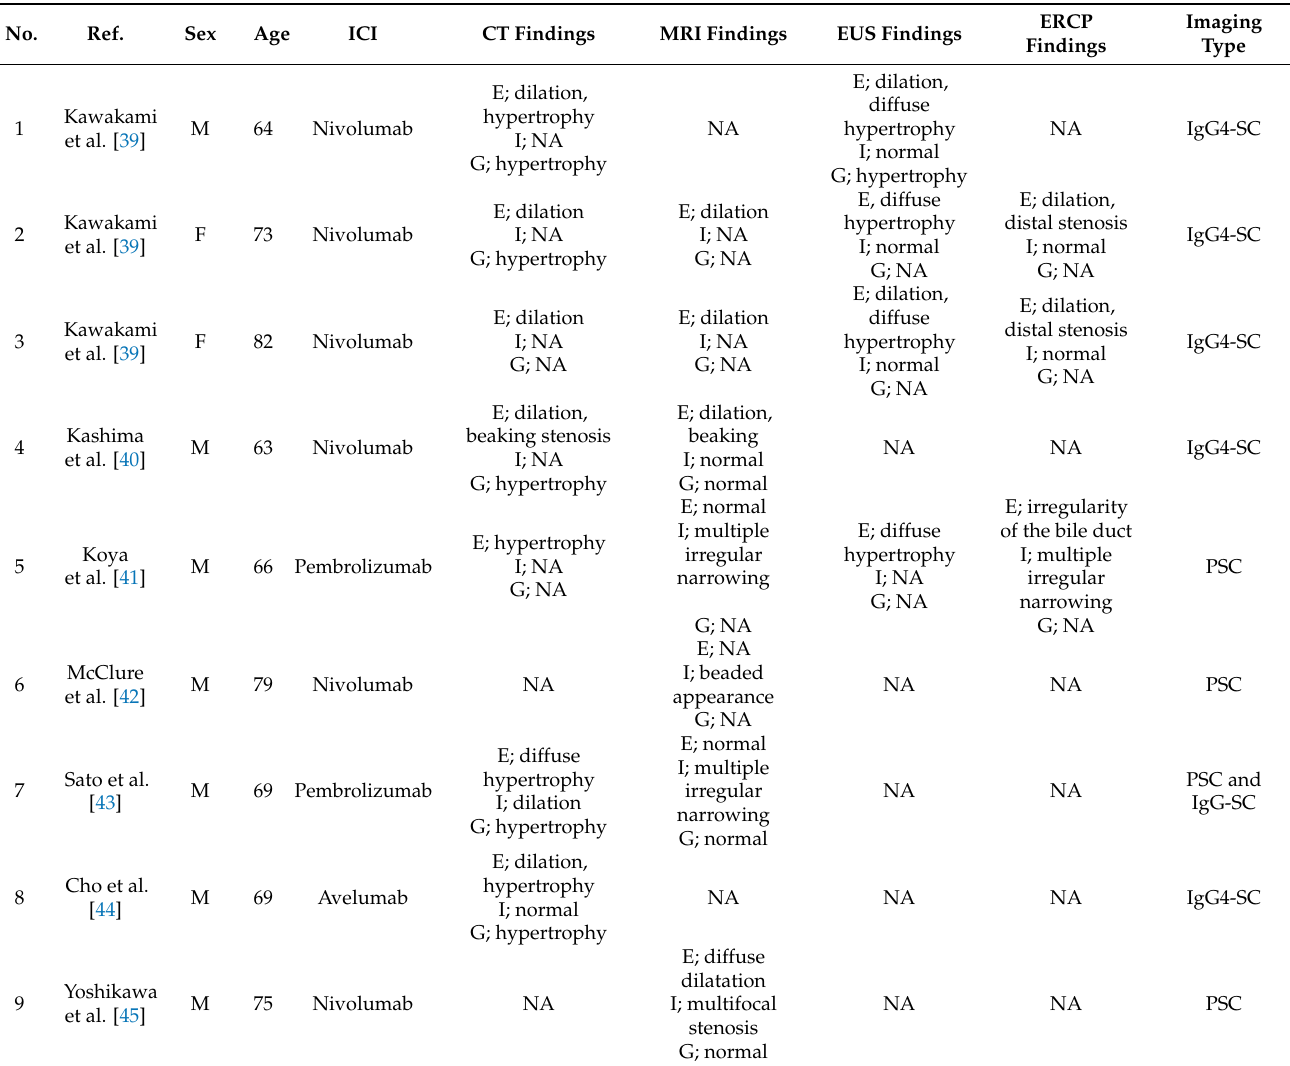
Table 2. Radiographic and endoscopic images of ICI-related